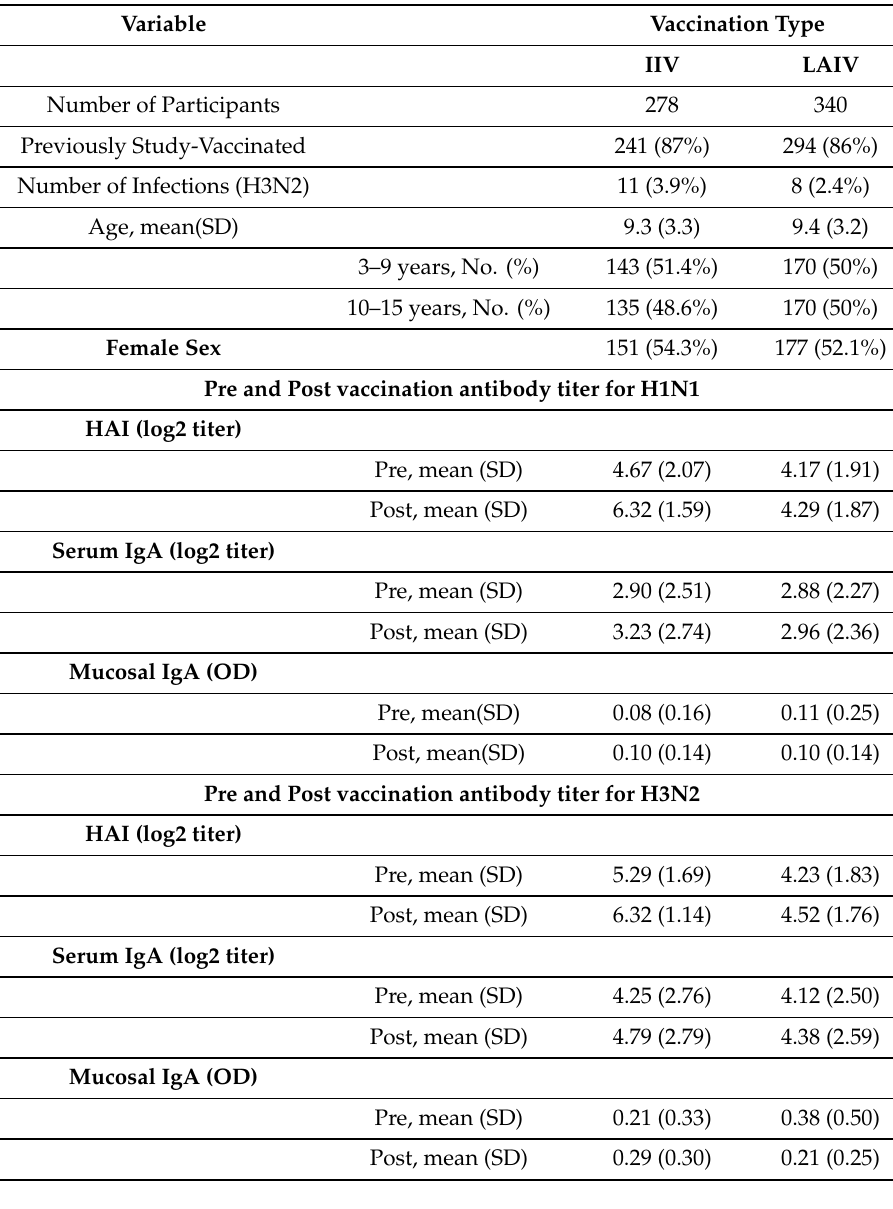
Table 1. Basic characteristics of the study participants and distributions of pre-and post-vaccination antibody